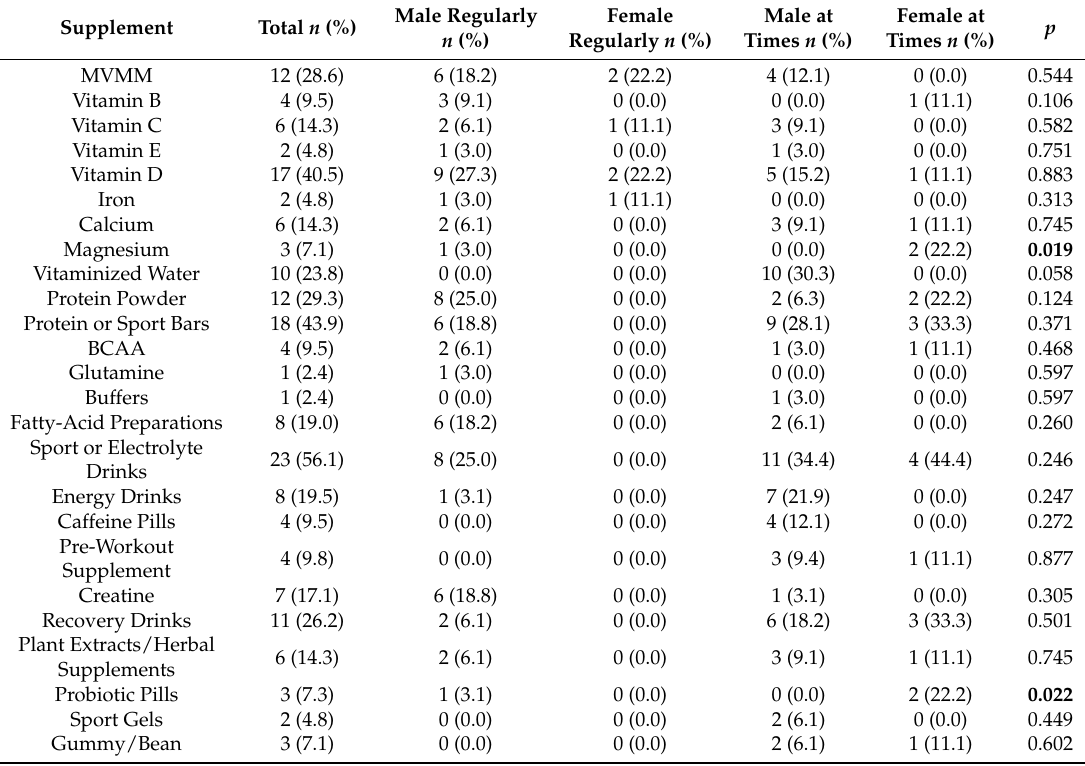
Table 2. Supplement use by